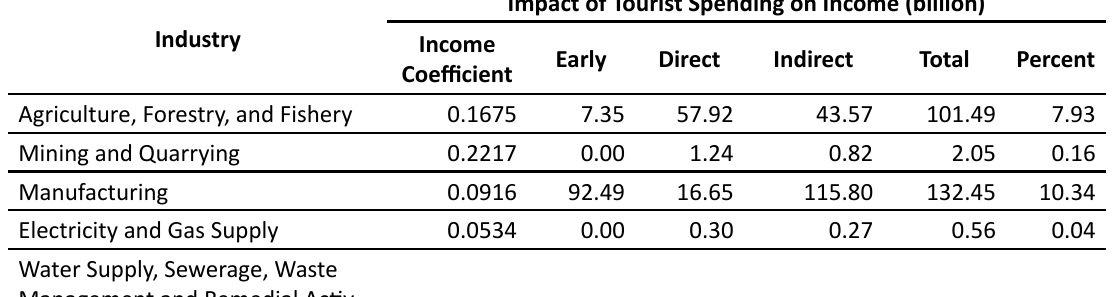
Table 8: Impact of Tourist Expenditure on Income North Sulawesi Province in 2018 Impact of Tourist Spending on Income (billion) Industry Income Coefficient